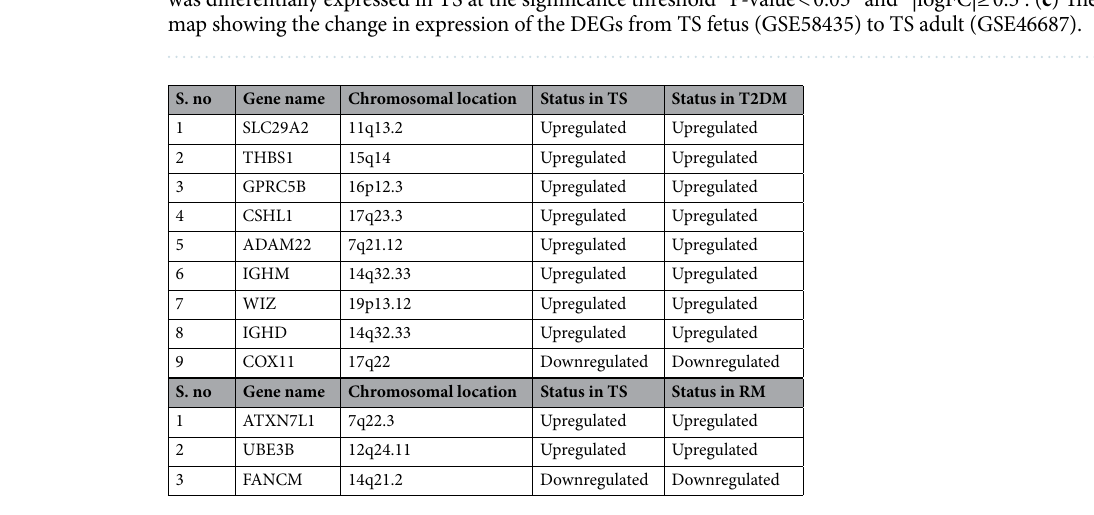
Table 2. List of signature genes of T2DM and RM in